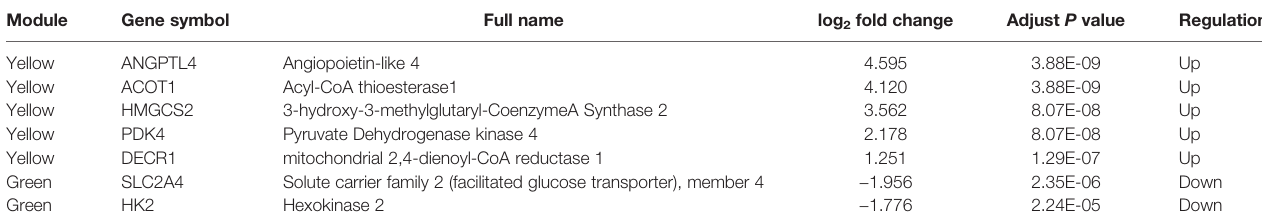
TABLE 2 | The selected hub genes in yellow and green modules. Module Gene